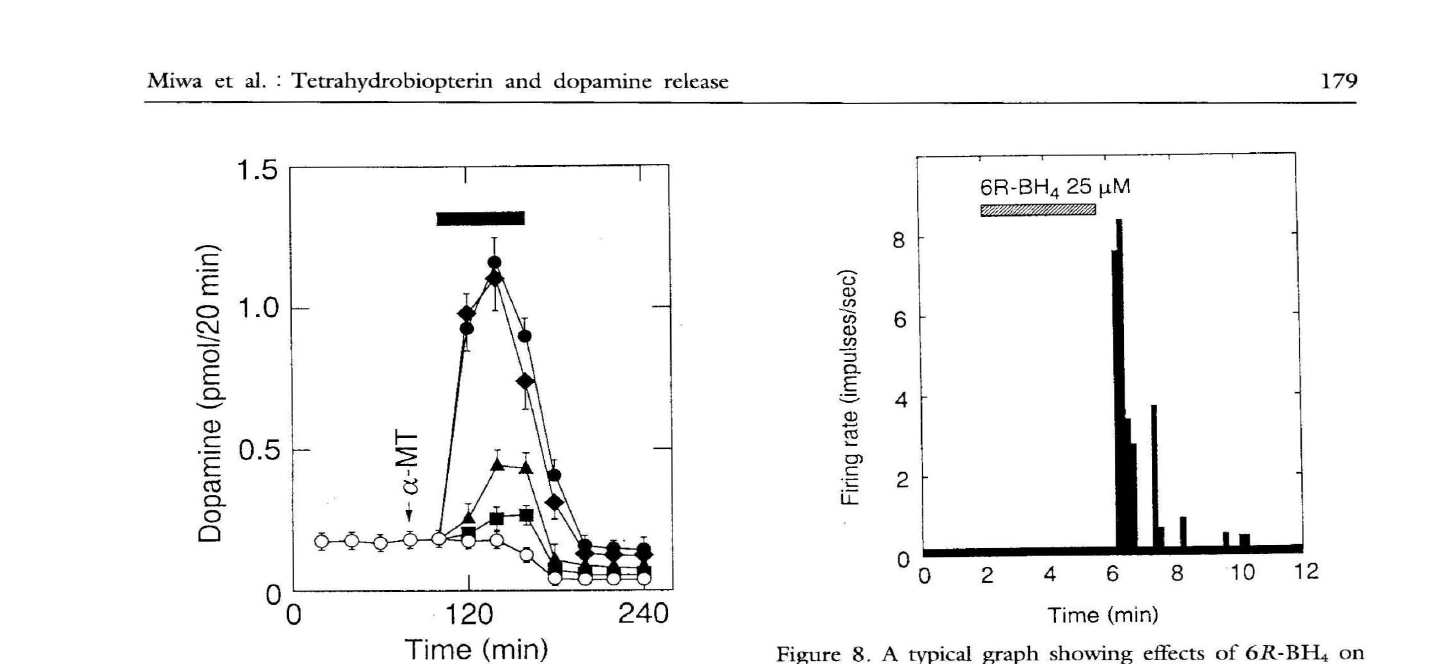
Figure 8 . A typical graph showing effects of 6R-Ba on firing rates of neurons in dorsal motor nucleus of vagus. Figure 7. Effects of biopterin, 6R-BH or 6-MPa add 4 Firing rates of neurons in the dorsal motor nucleus of ed to the perfusion fluid on the 6R-Ba-induced in 'vagus were monitored under current-clamp conditions us crease in DA levels in dialysates. Twenty minutes after ing a whole-cell recording mode of a slice patch method. i.p. injection of 250 mg/kg of a-MT (indicated by an ar 6R-BH was added to the perfusion fluid of the slices row), 6R-BH alone (filled circles) or in combination 4 4 during the time indicated by a with biopterin (filled diamonds), 6S-Ba (filled squares) or 6S-MPH (filled triangles) was added to the perfusion 4 fluid of microdialysis probes at the final concentration of 1mM. Empty circles represent a control group which was given 250 mg/ kg of a-MT alone. Each value is the mean ± SEM of four determinations.